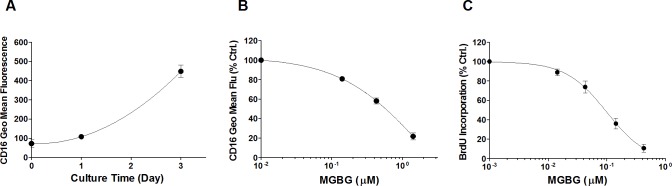
MGBG inhibited monocyte CD16 expression and BrdU incorporation.Isolated human monocytes were cultured in suspension with or without MGBG treatment. CD16 expression was measured by flow cytometry. (A). Monocytes differentiate spontaneously in culture. CD16 expression level increases in monocyte culture. n = 4, means and SEM. (B). MGBG inhibited CD16 expression in 1 day cultured monocytes in a dose-dependent manner. The average CD16 geometric mean fluorescence of 1 day untreated monocytes was measured at 108 units. n = 4, means and SEM. (C). MGBG inhibited BrdU incorporation in cultured monocytes. Isolated human monocytes were cultured for 3–6 days for BrdU incorporation using a FITC BrdU flow kit. The average percentage of BrdU incorporated untreated monocytes was measured at 4.7%. MGBG inhibited monocyte BrdU uptake in a dose-dependent manner. n = 5, means and SEM.